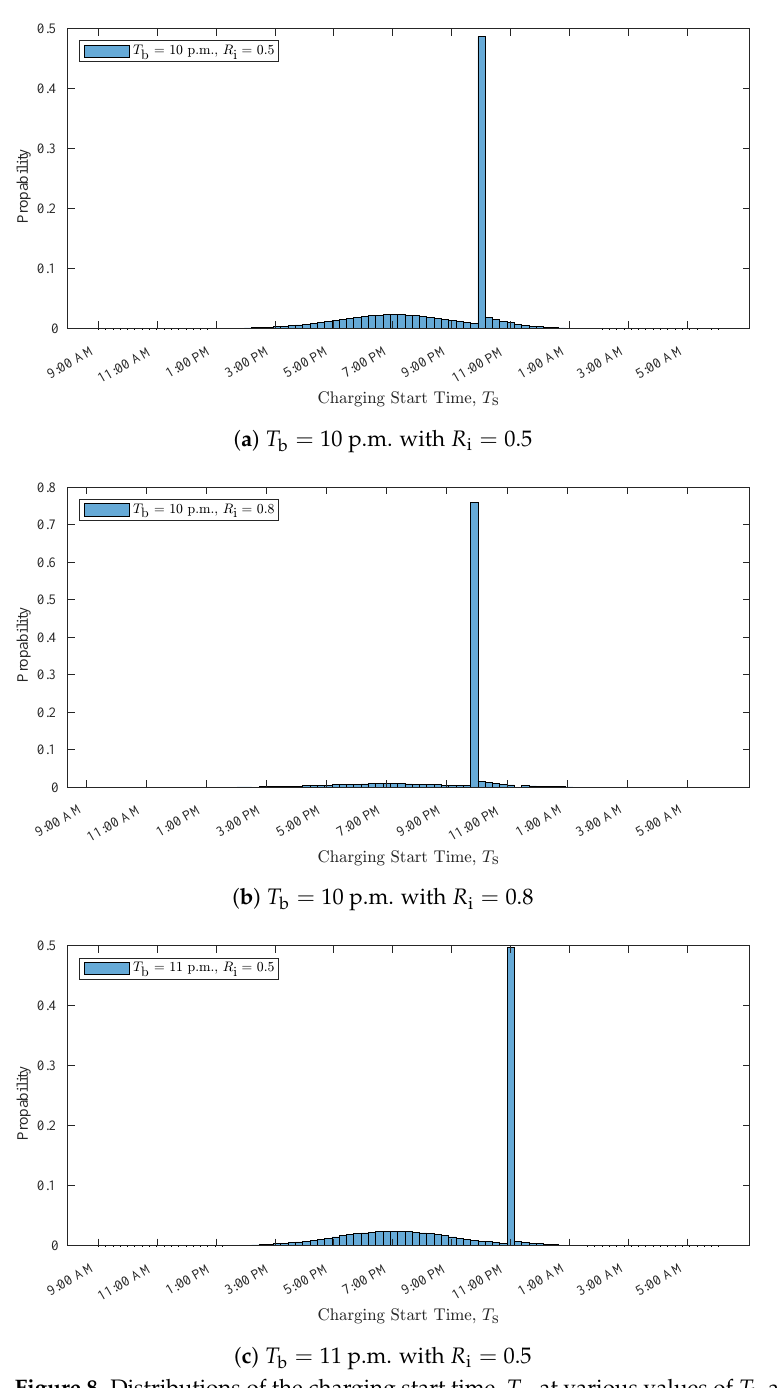
( c ) T b = 11 p.m. with R i = 0.5 Figure 8. Distributions of the charging start time, T s , at various values of T b and R i . It is clear from the results shown in Figure 9 that uncontrolled charging of electric vehicles can significantly increase the peak load demand on the power distribution system. The peak load demand increased by 5.8%, 11.7%, 17.5%, and 74.4% when the EV penetration levels were 10%, 20%, 30%, and 100%, respectively. These significant increases in peak load demand can strain the capacity of the PEA’s distribution feeders and highlight the need for a comprehensive strategy and incentives to encourage EV charging during off-peak times. For an uncontrolled charging scenario with the normal distribution of the SOC, the results showed that the peak load demand of the electrical distribution system increased by 5.8%, 11.5%, 17.3%, and 70.0% when the EV penetration levels were 10%, 20%, 30%, and 100%, respectively, as shown in Figure